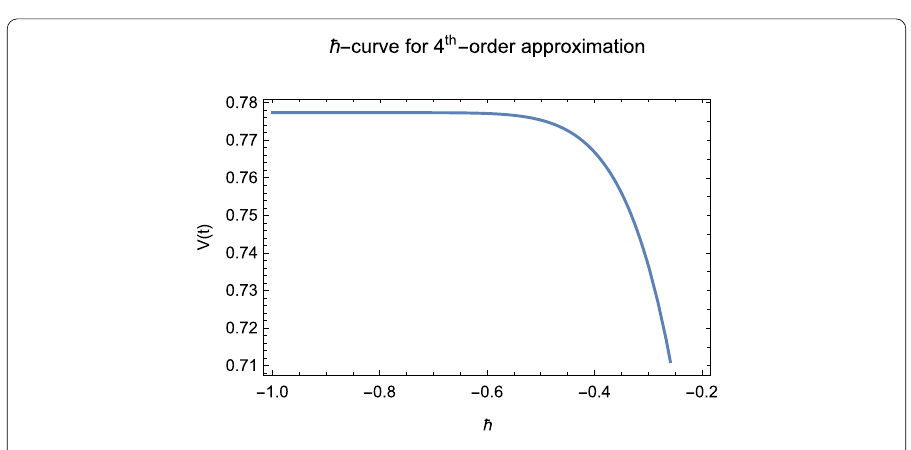
Figure 8 The h -curves of the fourth-order approximations for V ( t